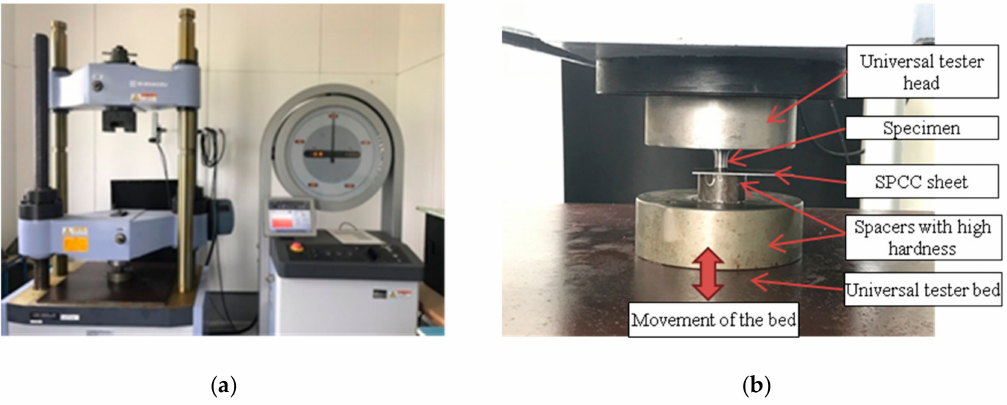
Figure 2. Testing machine and experimental setup: ( a ) universal testing machine (UH-500KNX); and, ( b ) experimental setup.